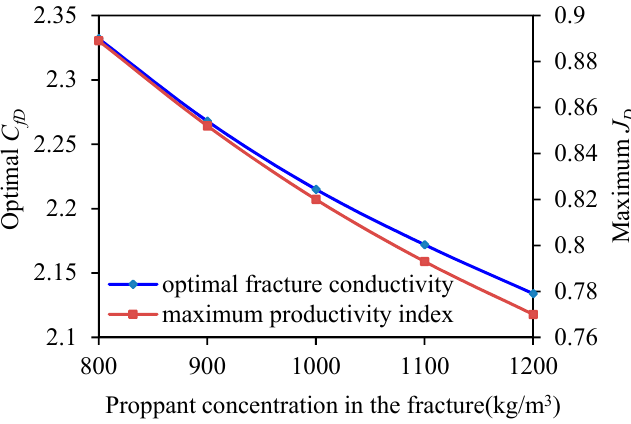
Figure 15. Optimal propped fracture half-lengths and widths according to proppant concentration.